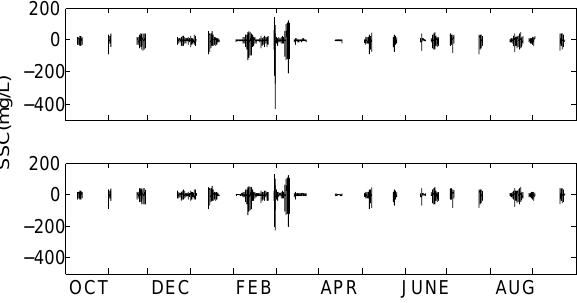
Figure 5. Residual series after removing reconstructed signals from the first 10 modes (top panel: SSAM; bottom panel: